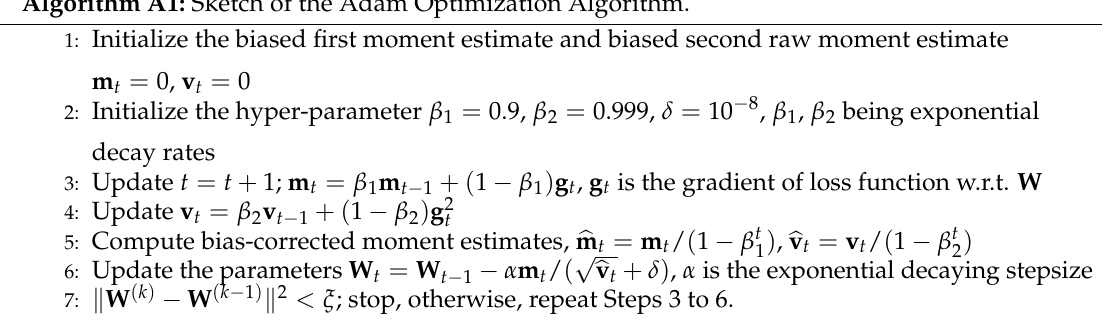
Algorithm A1: Sketch of the Adam Optimization